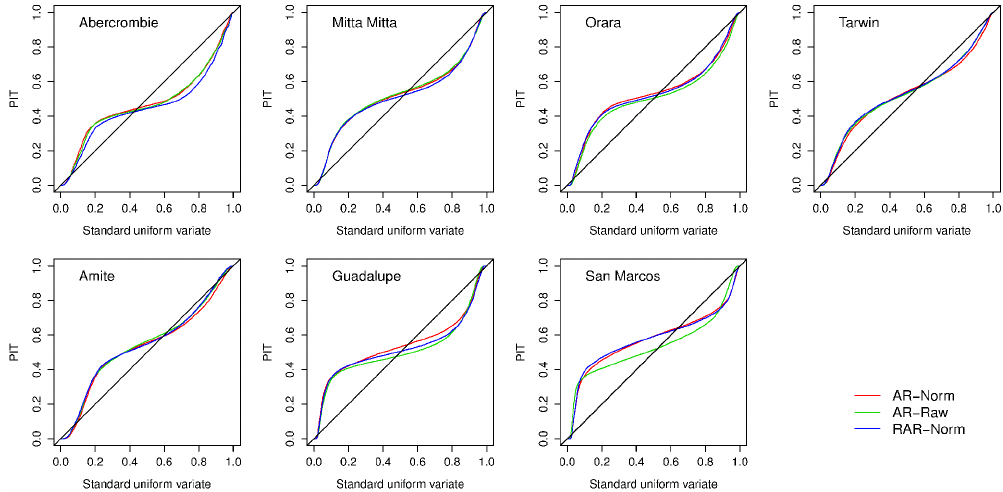
Figure 9. PIT uniform probability plots. Curves on the diagonal indicate perfectly reliable forecasts.